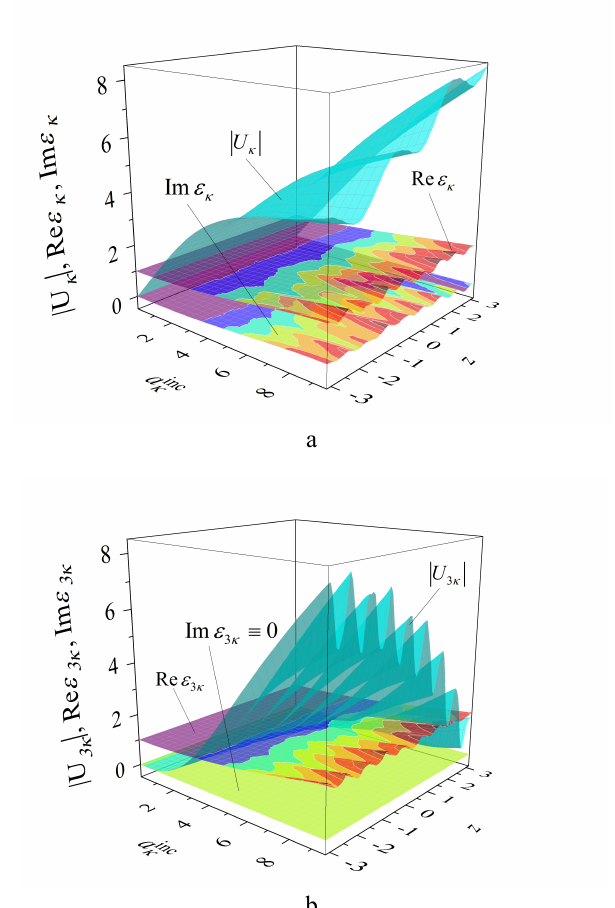
Figure 7: The amplitude characteristics and induced permittivities for at (a) the scattering frequency , (b) the generation frequency